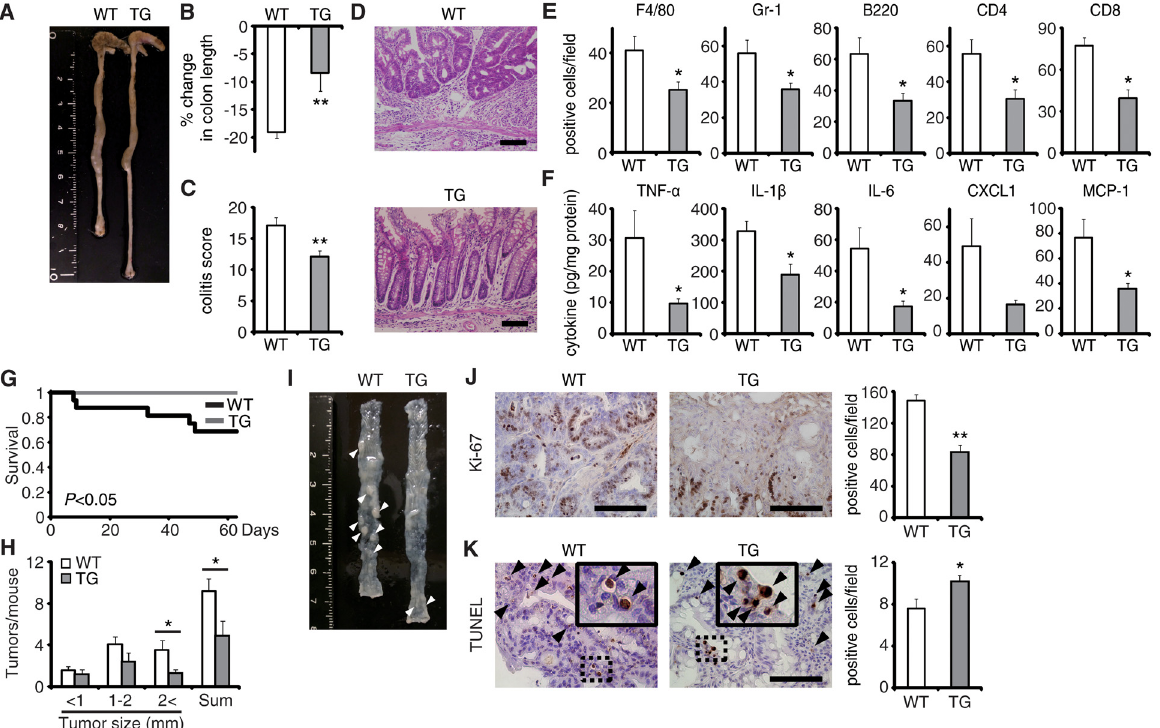
Fig 5. EPRAP overexpression in macrophages ameliorates DSS-induced colitis and colitis-associated tumorigenesis. (A) Representative photographs of colons at the end of DSS treatment; colons were obtained from WT and CD68 – mEPRAP transgenic (TG) mice. (B) Percent changes in colon length expressed relative to DSS-free water controls (n = 8 [WT]; n = 6 [TG]). (C) Histological colitis scores (n = 10 [WT]; n = 8 [TG]). (D) Representative H&E staining of rectal sections. (E) The numbers of F4/80-, Gr-1 – , B220-, CD4-, and CD8-positive cells infiltrated in colonic tissues of WT and TG mice, per high- power field (400× magnification) (n = 8 each). (F) The expression levels of TNF- α , IL-1 β , IL-6, CXCL1, and MCP-1 protein in colonic tissue lysates from DSS- treated WT and TG mice (n = 15 [WT]; n = 8 [TG]). (G) Survival curves during the course of AOM/DSS treatment in WT and TG mice (n = 18 [WT]; n = 11 [TG]; P < 0.05). (H) The numbers of colonic polyps per mouse, with size distribution (left) and total number (right) in colonic tissues of AOM/DSS-treated WT and TG mice (n = 9 [WT]; n = 10 [TG]). (I) Representative photographs of colons at the end of AOM/DSS treatment. (J) Ki-67 – positive cells in rectal polyps of AOM/DSS-treated WT and TG mice (left). TG mice exhibited markedly fewer Ki-67 – positive cells than WT mice (n = 5 each) (right). (K) Representative photographs of TUNEL assay performed on rectal polyps of AOM/DSS-treated WT and TG mice. The arrows indicate TUNEL-positive apoptotic cells: the insets show higher magnifications of selected regions (indicated by dashed boxes) (left). TG mice exhibited more TUNEL-positive cells than WT mice (right) (n = 5 each). All values represent means ± SEM. * P < 0.05, ** P < 0.01 vs. WT mice. Scale bars: 100 μ